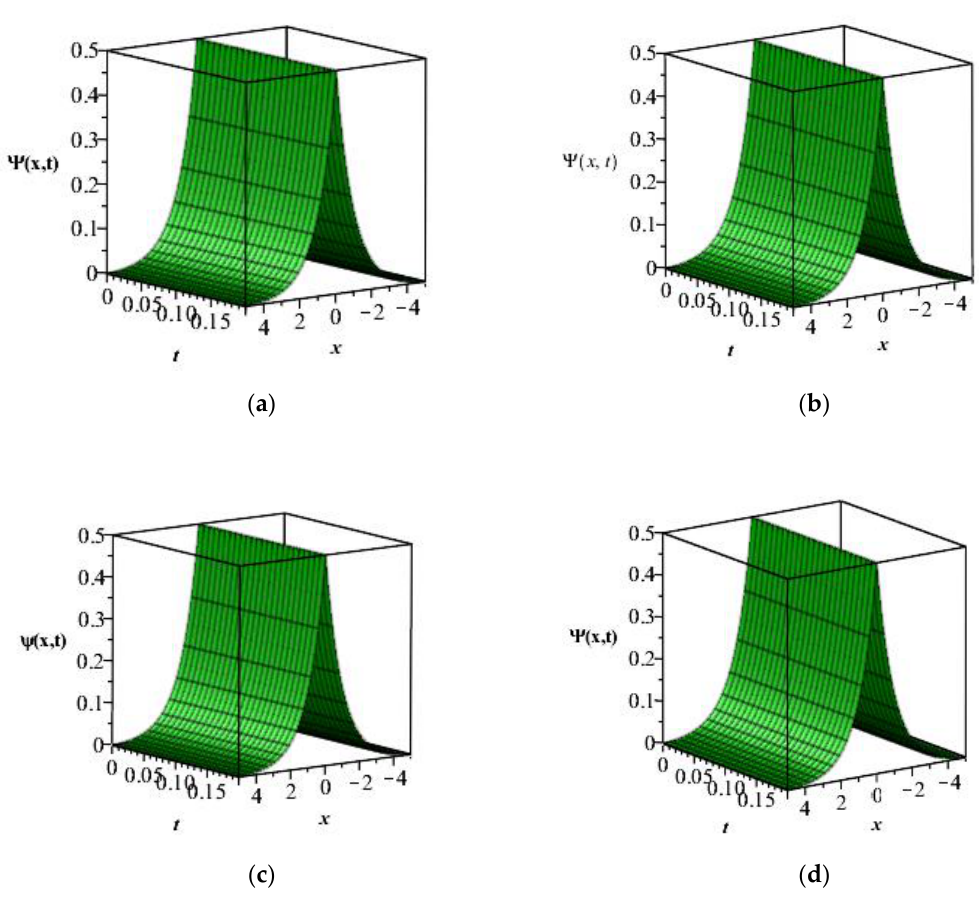
Figure 1. The solution plots of